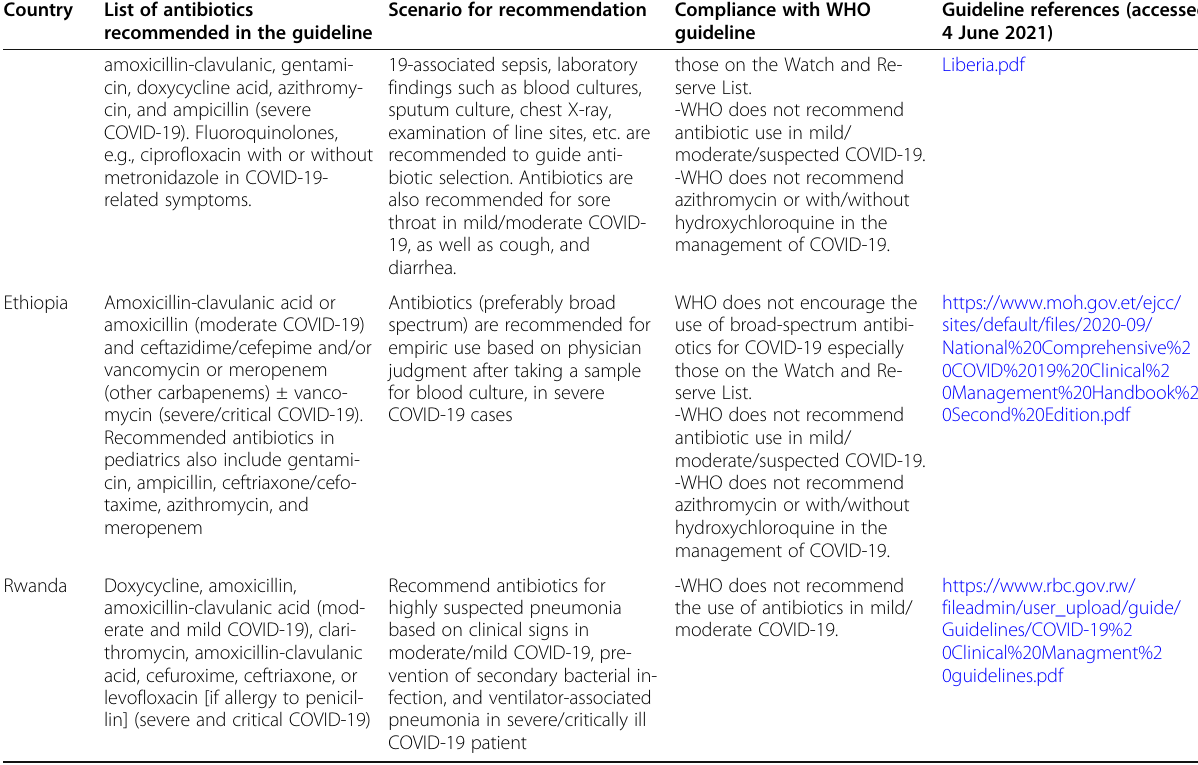
Table 1 The use of antibiotics in COVID-19 management in 10 African countries (Continued) Country List of antibiotics Scenario for recommended in the guideline